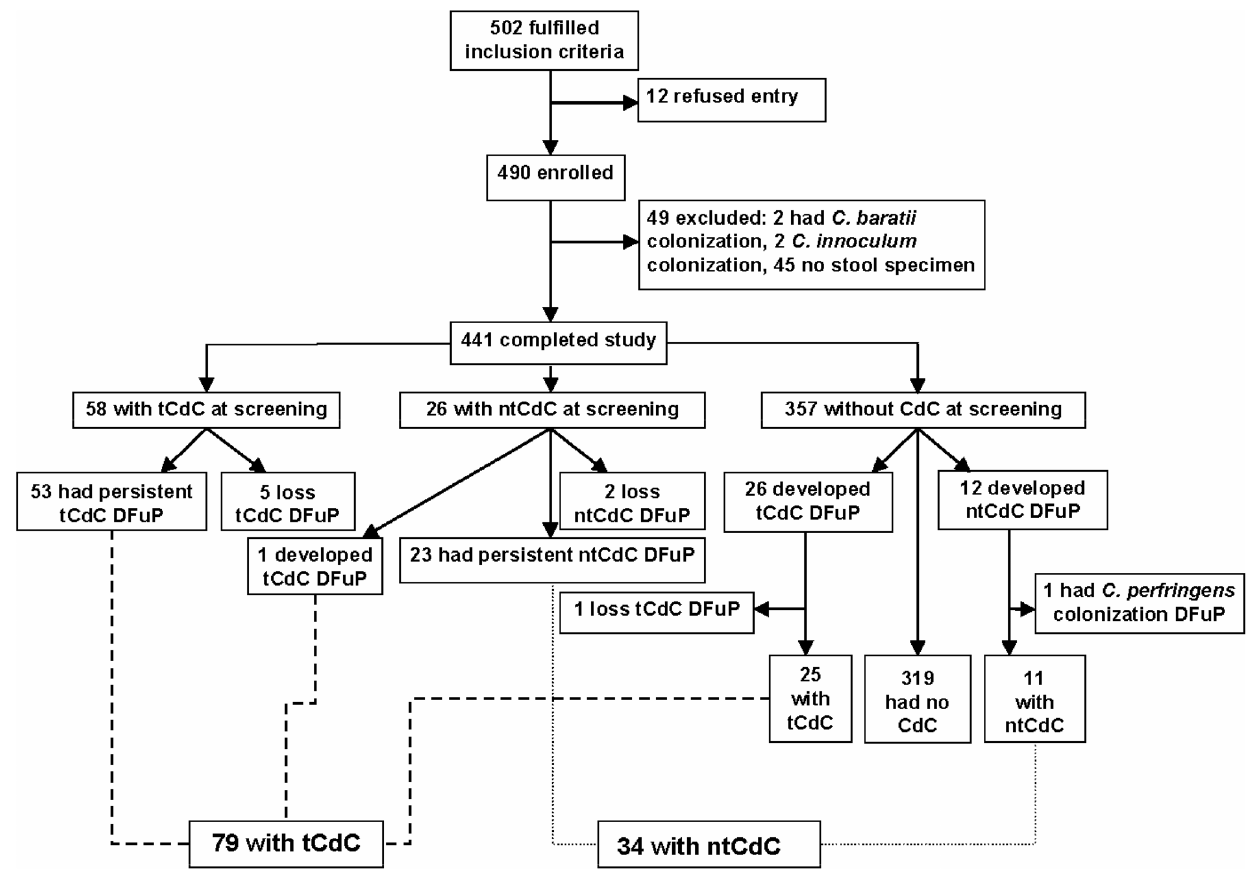
Figure 1. Results of screening for fecal toxigenic and nontoxigenic Clostridiumdifficile colonization at the study hospital. Note: tCdC=toxigenic Clostridium difficile colonization; ntCdC=nontoxigenic C. difficile colonization; DFuP=during follow-up period.